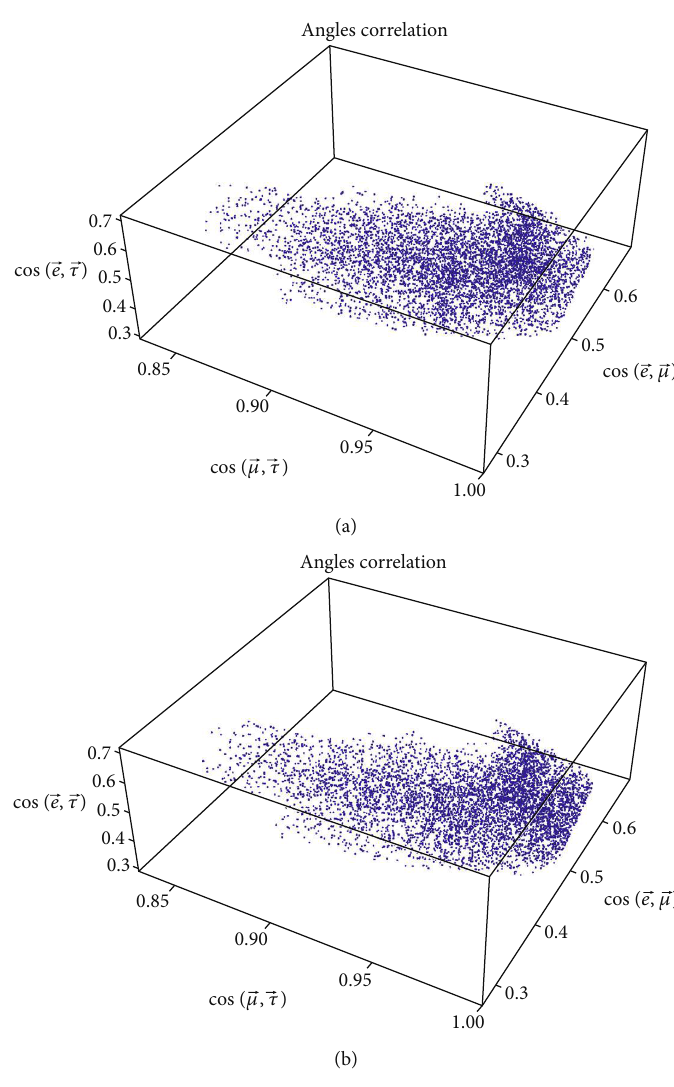
Figure 1: Three-dimensional scattered plots of the included angles based on the recent global fi t data listed in Table 1. (a) NO case. (b) IO